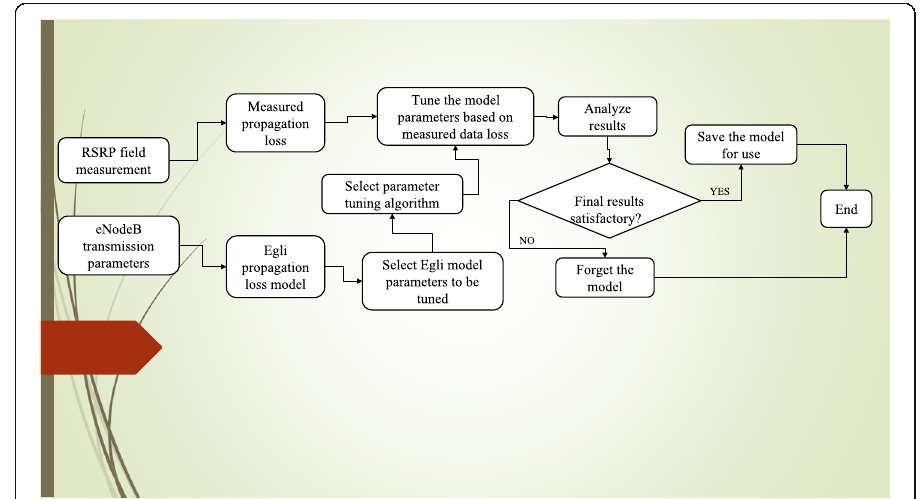
Fig. 1 Block diagram showing the methodology of pathloss measurements and